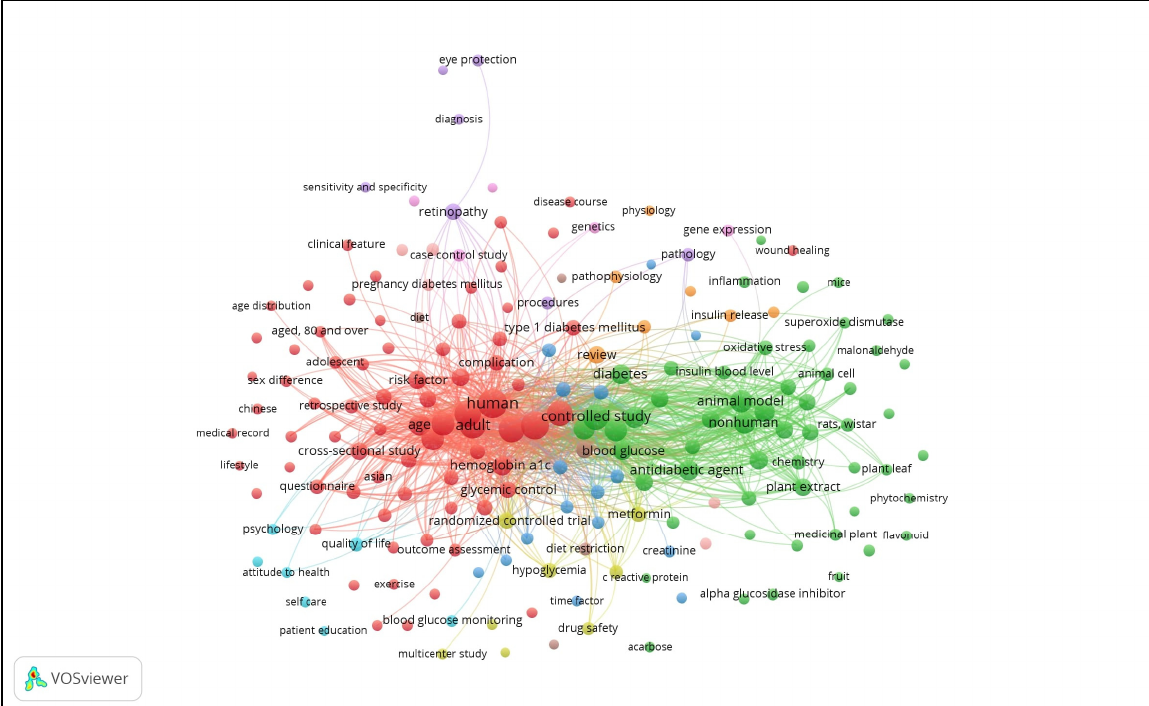
Figure 10. Radar chart showing the keyword links visualization of the diabetes research output. Note: The threshold was set at ≥ 35 occurrences. Keywords shown in the same color are closely related and clustered together. The size of nodes and words represent weights; the bigger the nodes and words, the larger the weights. The distance between two nodes reflects the strengths between them; a shorter distance means stronger relations. The line between two keywords means that they appeared together; the thicker the line, the higher the co-occurrence. Table 4. Frequent keywords and cluster conceptualization.